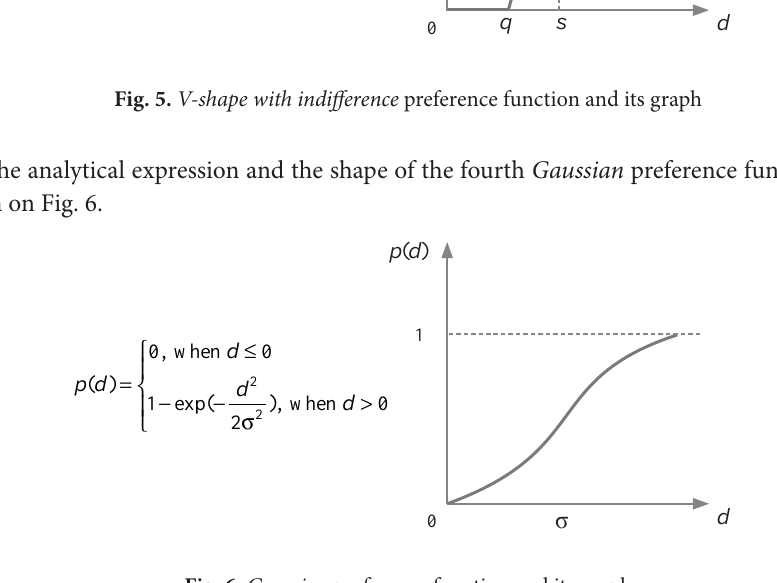
Fig. 6. Gaussian preference function and its